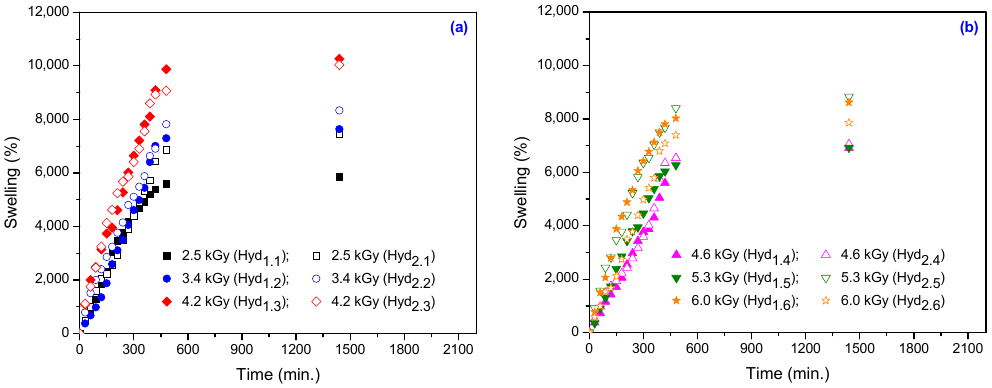
Figure 3. The effect of the amount of TMPT and PP on the swelling for hydrogels obtained at: ( a ) 2.5 kGy, 3.4 kGy and 4.2 kGy; ( b ) 4.6 kGy, 5.3 kGy and 6.0 kGy.